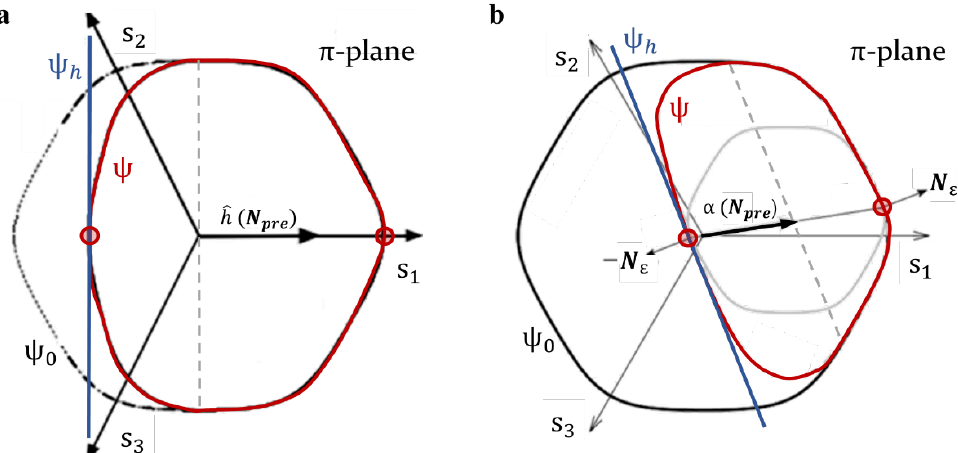
Figure 4. Normalized yield surfaces obtained with models that describe the Bauschinger effect with a fluctuating function ( ψ h ): ( a ) HAH 11 and ( b ) Holmedal 19